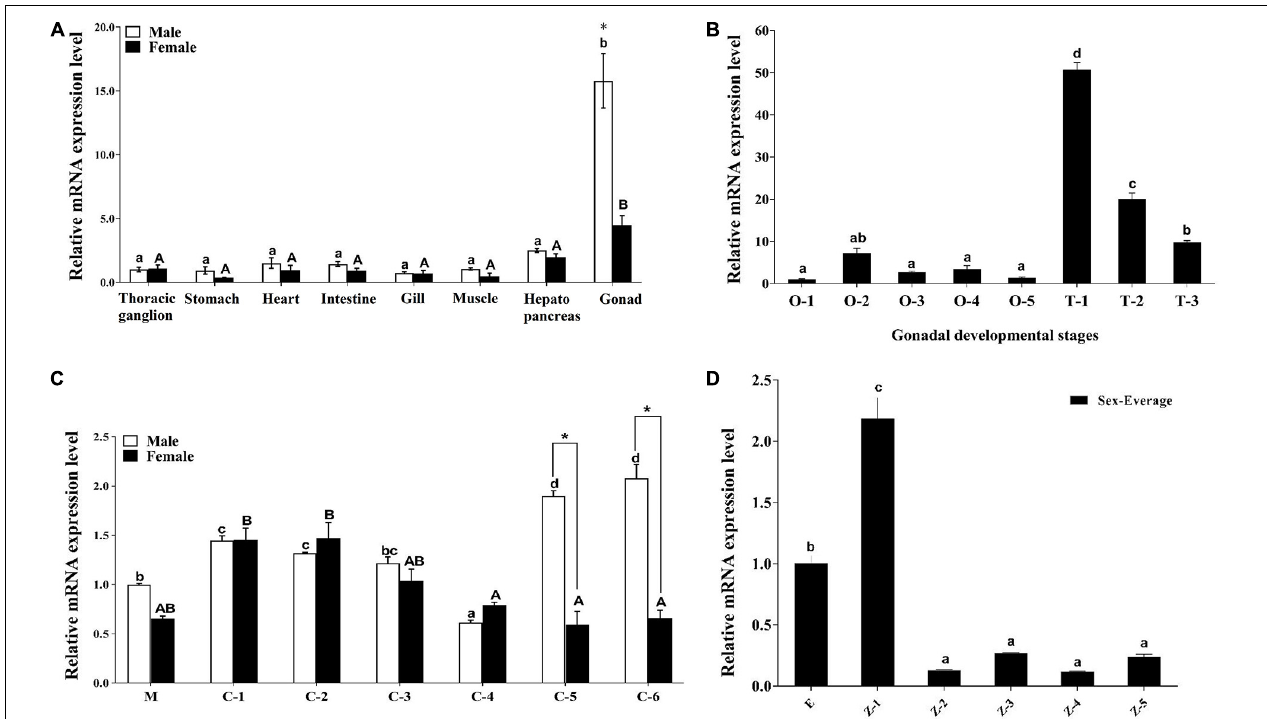
FIGURE 6 | The expression profiles of Sp-Pol in different tissues and different sexual developmental stages. (A) The expression of Sp-Pol mRNA in different tissues. (B) The expression of Sp-Pol mRNA at different gonadal development stages (O, ovary; T, testis). (C) The expression of Sp-Pol mRNA during different juvenile stages (M, megalopa larva stage; C, crablet stage). (D) The expression of Sp-Pol mRNA during larvae development (E, eggs hatch; Z, zoea stage). Significant differences are indicated with different letters and * mark ( P < 0.05). Values are mean ( ± SE).